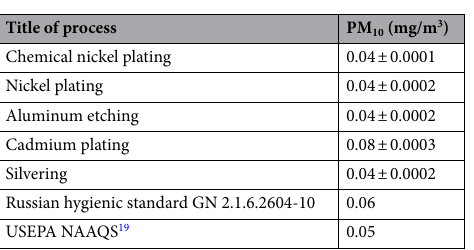
Figure 3. Size distribution of particles in sample 1) No. 4 (aluminum degreasing), and 2) No. 12 (nickel plating).